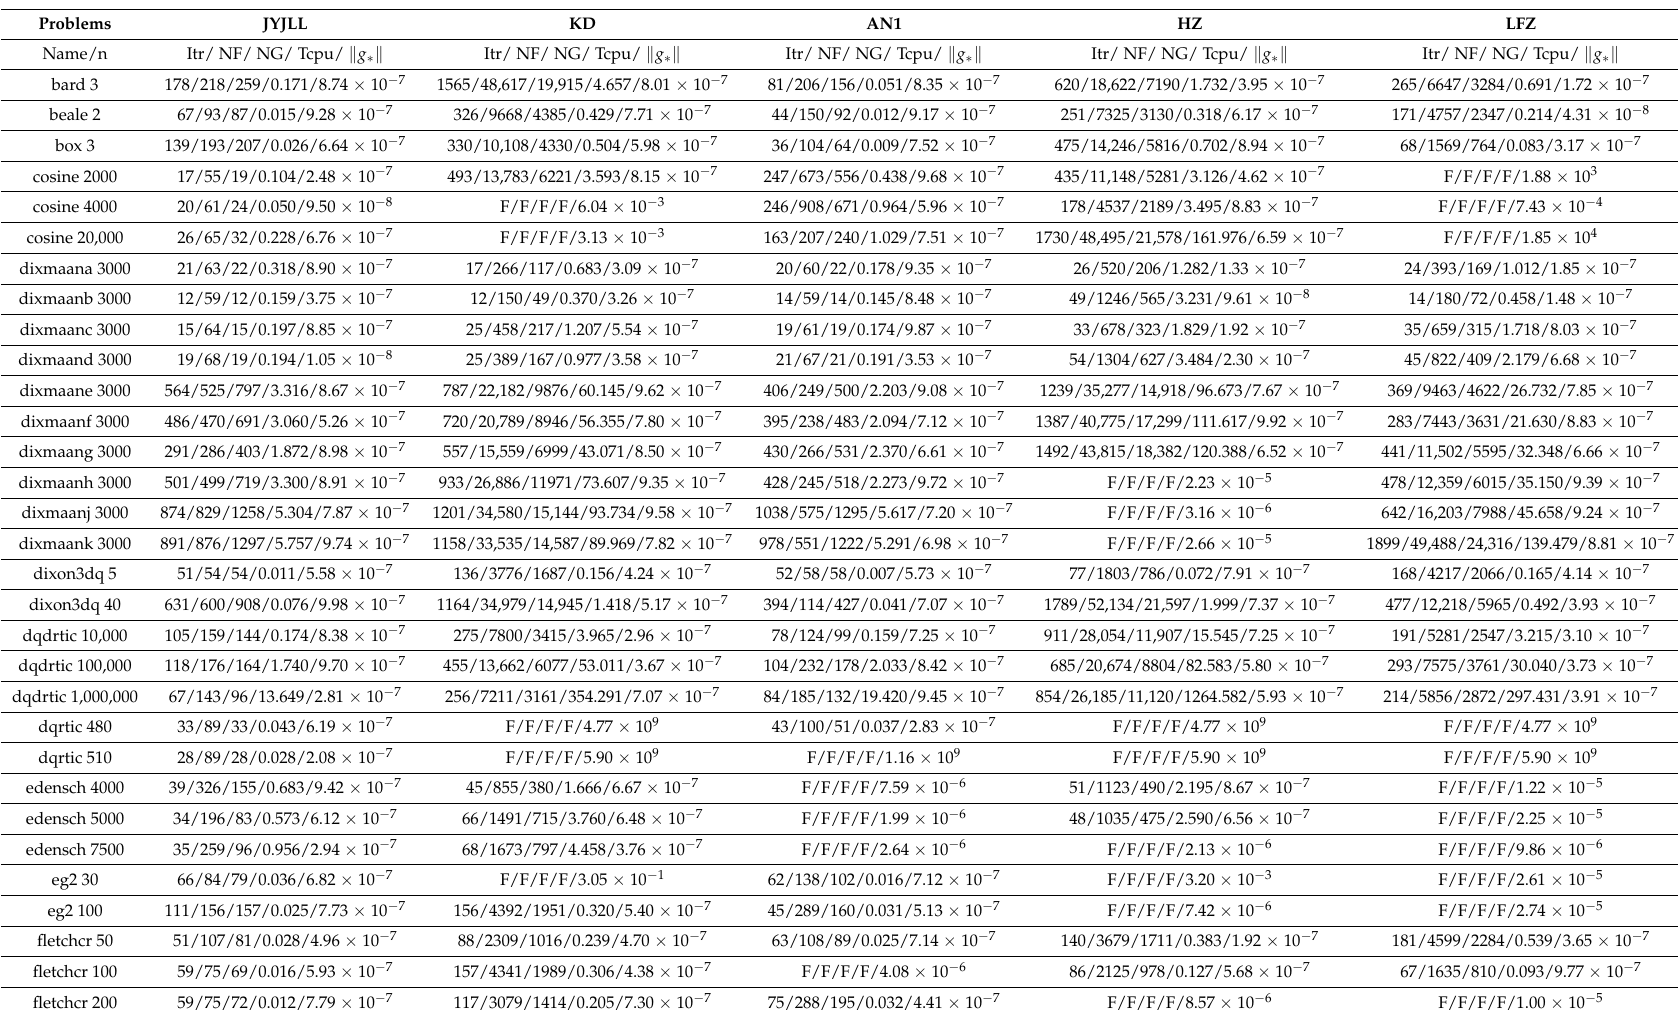
Table 1. Numerical test reports for the five tested